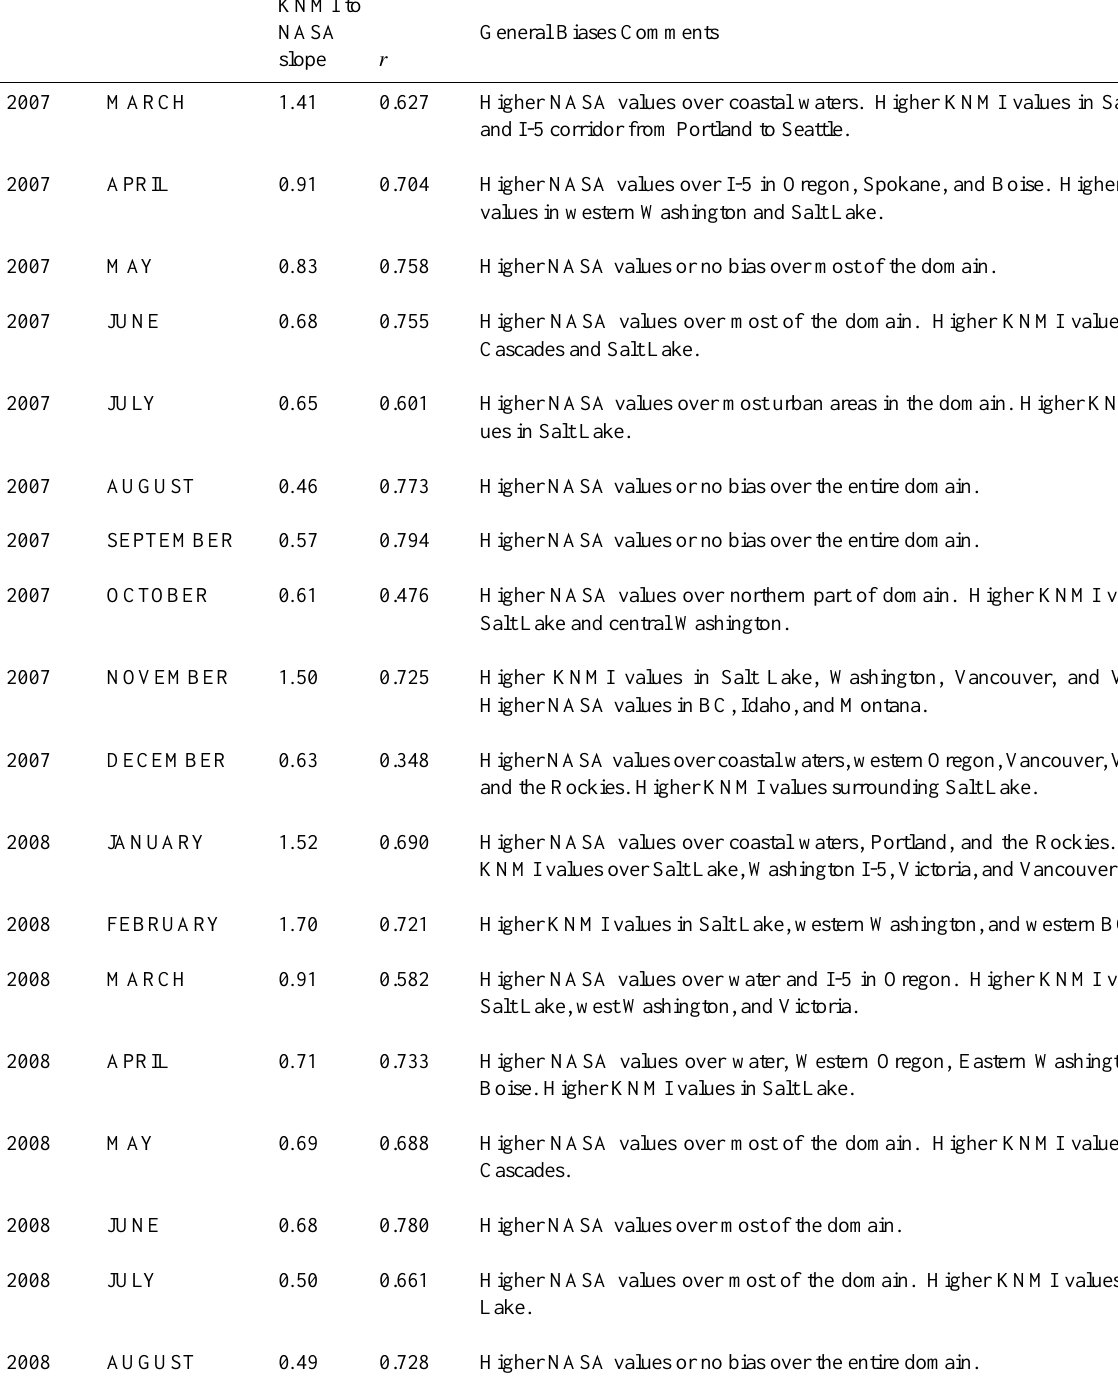
Table 3. Linear correlation and best fit slope of KNMI to NASA OMI tropospheric NO 2 column monthly averages for the analyzed domain. General biases are